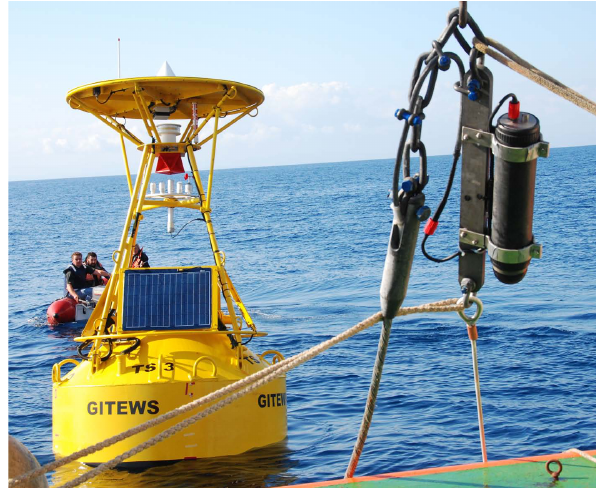
Fig. 6. HAM.node modem (dark cylinder, right) and hosting sur- face buoy (yellow, left) during tests in the Mediterranean offshore Toulon. The HAM.node modem is attached to a steel girdle in-line with the mooring